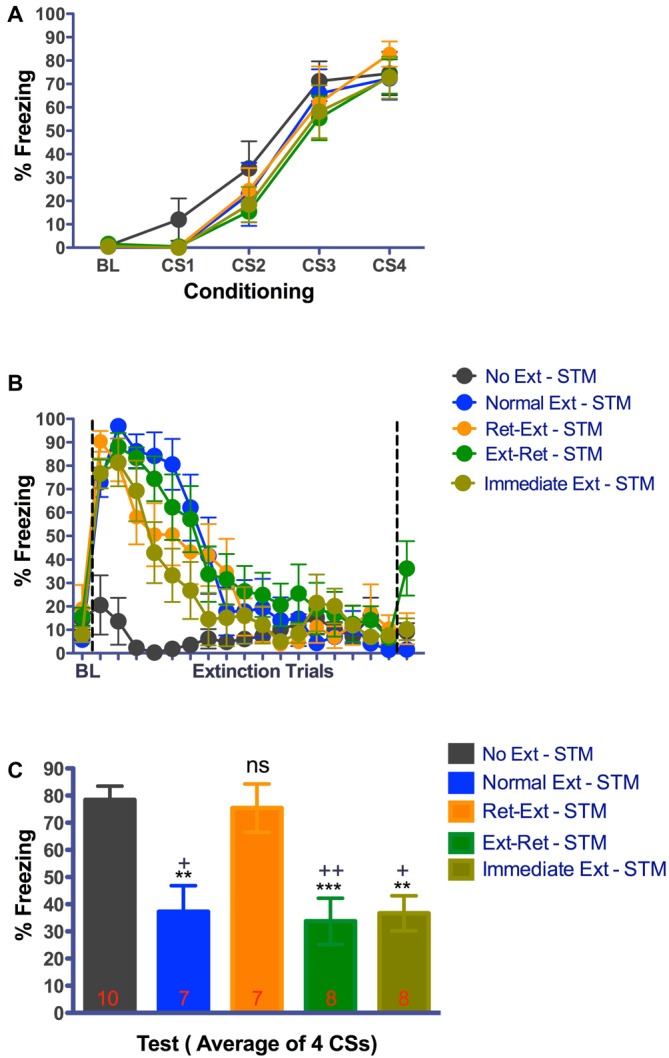
Rats failed to show extinction memory 3.25 h after successful retrieval—extinction session. (A) Fear acquisition. Rats were fear conditioned with four tone-shock pairings on Day-1 in context A. All animals acquired cue fear. (B) Fear retrieval and extinction. Rats received retrieval and extinction procedures in context B on Day-4. Immediate extinction group was fear conditioned in Context A with four tone-shock pairing and 10 min later they received normal fear extinction session in context B. All groups showed significant within session extinction learning on Day-4. Each data point for extinction trials represent average of 3 CSs except the 17th data point that represents average of 2 CSs totaling 53 CSs. Data point after the line break represent the average of 3 retrieval CSs for Ret-Ext and Ext-Ret groups. (C) Short-term fear extinction memory test. Rats received four tone only presentations in context B 3.25 h after the extinction procedures. Normal Ext, Ext-Ret, Immediate Ext groups showed significant low fear memory where as Ret-Ext group showed no traces of extinction memory in this test. Extinction during reconsolidation did not cause immediate memory erasure. One-Way ANOVA with Tukey’s multiple comparison test was used for Day-4. (ns, not significant; **P < 0.01; ***P < 0.001 vs. No Extinction (C). +P < 0.05; ++P < 0.01 vs. Ret-Ext. Groups: No Ext, no extinction; Normal Ext, normal extinction; Ret-Ext, retrieval first + extinction; Ext-Ret, extinction + retrieval later; Immediate Ext, Fear conditioning first + immediate extinction. To avoid any potential confounding effect of the test by itself, rats tested in short-term memory after extinction were not used on 24 h memory test.